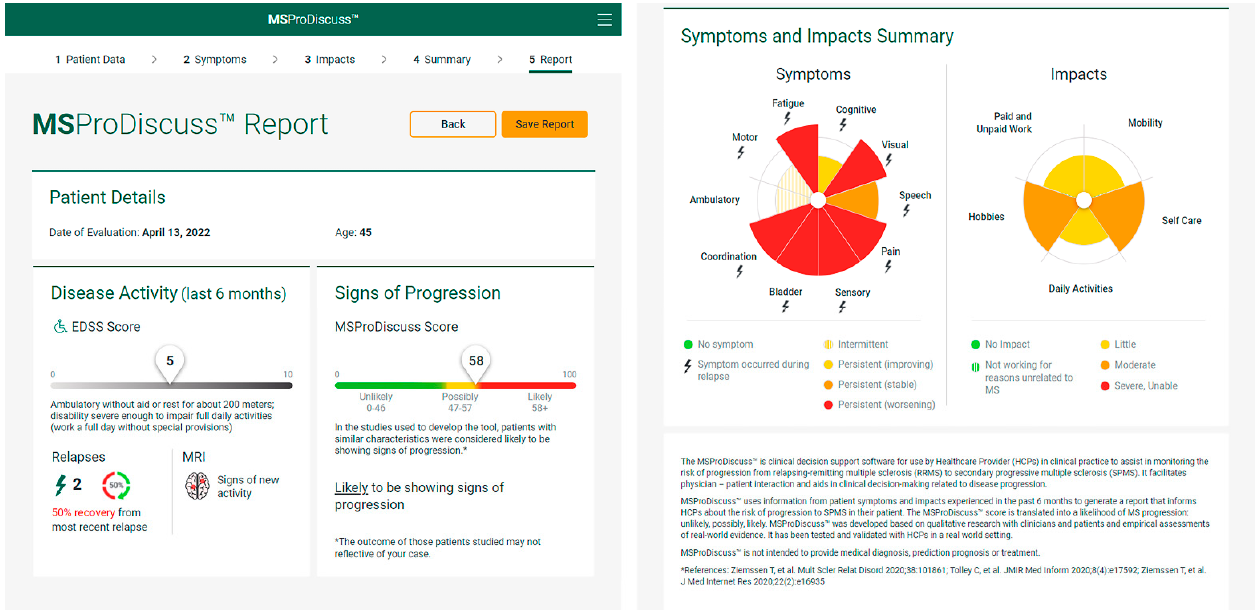
Figure 3. Example outcome report from MSProDiscuss. Figure shows a screen shot of the output report that will become available following CE mark certification (see ‘Regulatory classification’ section for further details) and reproduced with permission from Novartis Pharmaceuticals Corporation. Copyright 2021, Novartis Pharmaceuticals Corporation. EDSS, expanded disability status scale; MRI, magnetic resonance imaging [34,38,39].